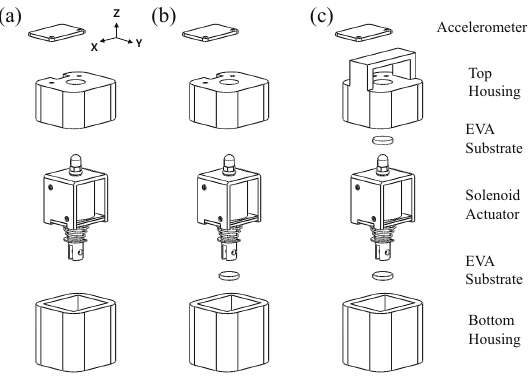
Figure 3. Ten different daily surfaces explored in this study. ( A ): Softwood table, ( B ): Synthetic wood table, ( C ): Plywood table, ( D ): Polyurethane chair, ( E ): Cutting mat, ( F ): Granite tile, ( G ): Porcelain tile, ( H ): Metal plate, ( I ): ABS (acrylonitrile butadiene styrene) plastic table, ( J ): Laminate table.